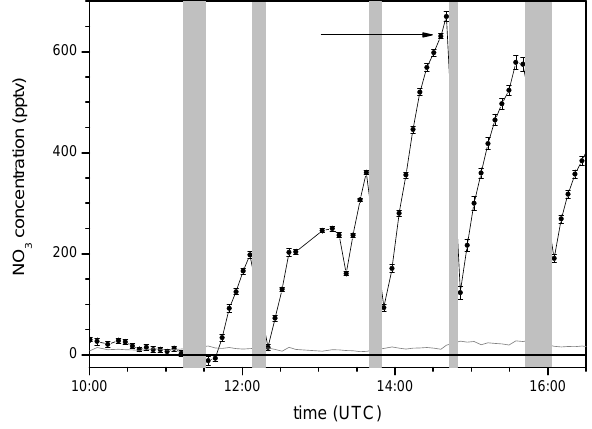
Fig. 7. Time series for NO 3 concentration of one experiment day. Each point represents a concentration accessed by DOAS analysis. The grey line near the bottom of the plot denotes the 2 σ precision of the individual fit result. The data point marked by an arrow was obtained by analyzing the data shown in Fig. 5 and Fig. 6. The solid bars indicate periods were the roof was open and photolysis of NO 3 occurred.